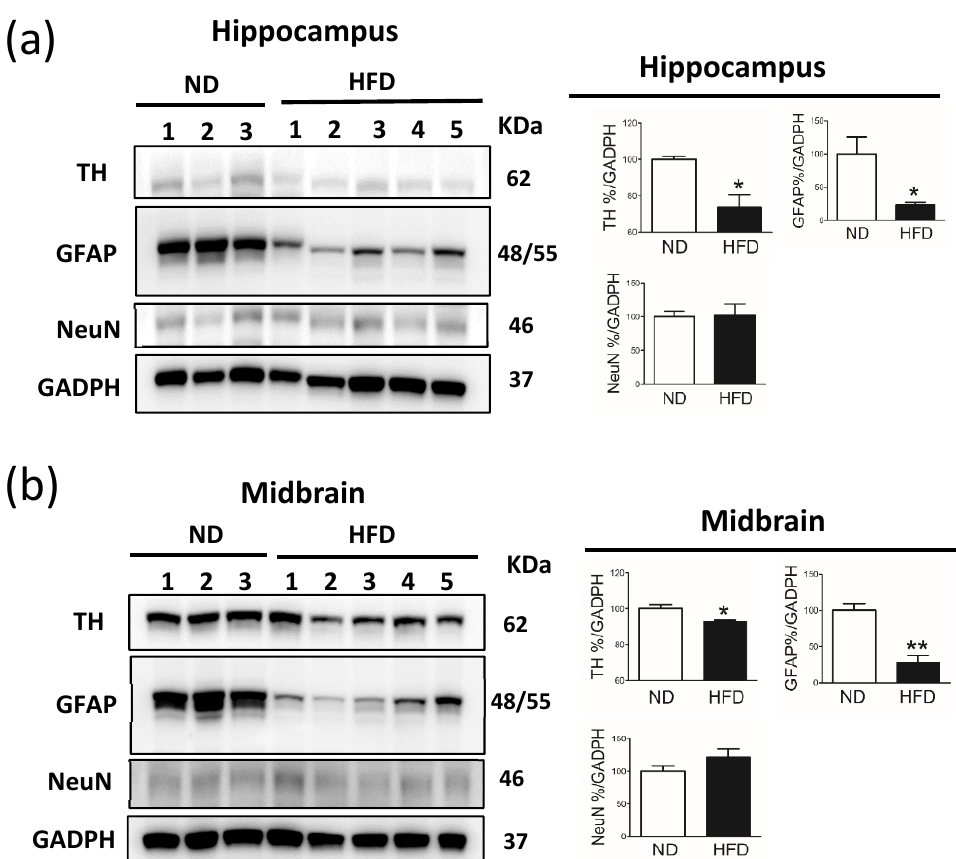
Figure 8. Western blot analysis of GFAP (astrocytes), TH (DA neurons), and NeuN (pyramidal neurons) in the hippocampus and midbrain of middle-aged rats after rats were fed a normal diet (ND, n = 3) or 45% high-fat diet (HFD, n = 5) for 30 weeks. Immunoblotting of the ( a ) hippocampus and midbrain of rats from the ND or HFD group. As shown in ( b ), the GFAP%, TH%, and NeuN% were quantified in the hippocampus and midbrain. Data are presented as the mean ± SEM. * p < 0.05, ** p < 0.01 vs ND rats ( t -test).